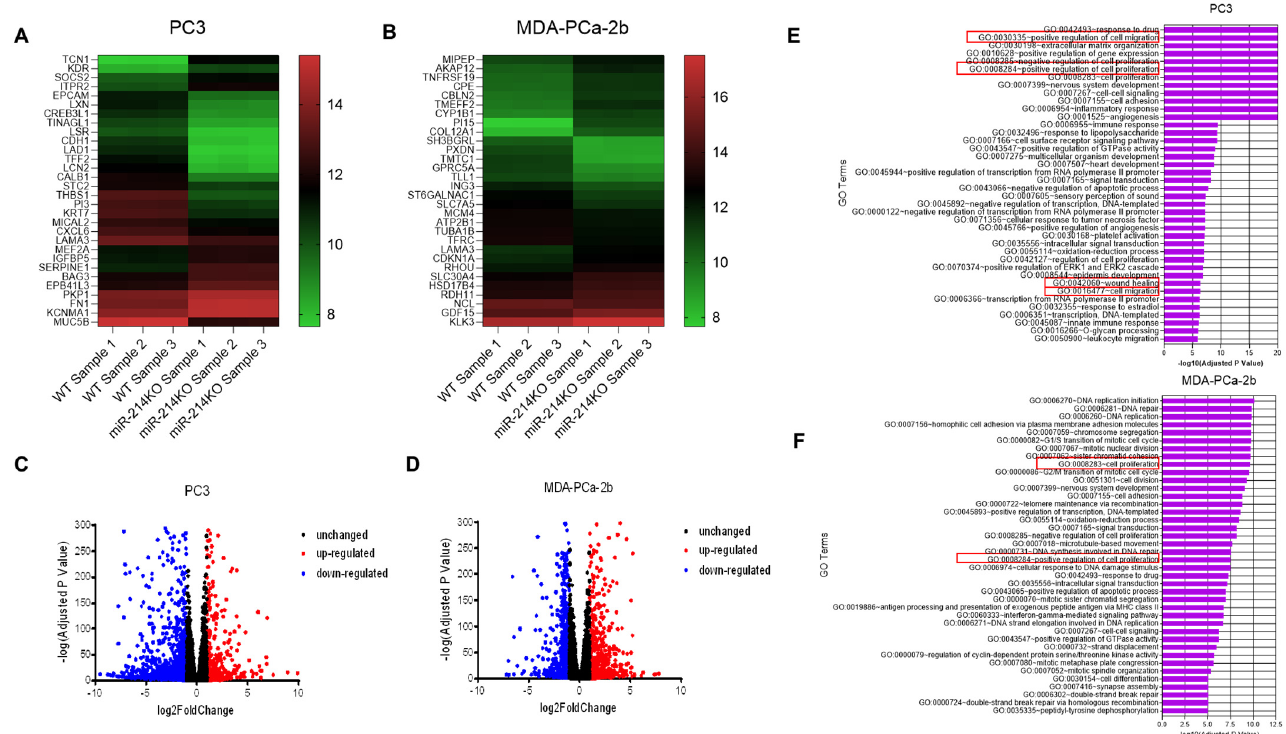
Figure 4. Identification and modulation of differentially expressed genes in miR-214-deleted PCa cells. Gene expression analysis was performed on the cells to compare the expression level of genes between WT and miR-214KO PCa cells. The differential miRNA expressional profiles from PC3 ( A ) and MDA-PCa-2b ( B ) cells miR-214KO compared with that in normal WT cells determined using RNA-Seq assays. Green represents relatively lower expression, and black/red indicates relatively higher expression. Volcano plot of the differentially expressed genes in PC3 ( C ) and MDA-PCa-2b ( D ) miR-214KO cells. Overexpressed genes are demonstrated in red and downregulated genes are demonstrated in blue. GO enrichment analysis of the differentially expressed mRNAs in PC3 (E) and MDA-PCa-2b ( F ) miR-214KO cells (Top 40 GO enrichment are presented, red box= enriched cell proliferation and migration processes).